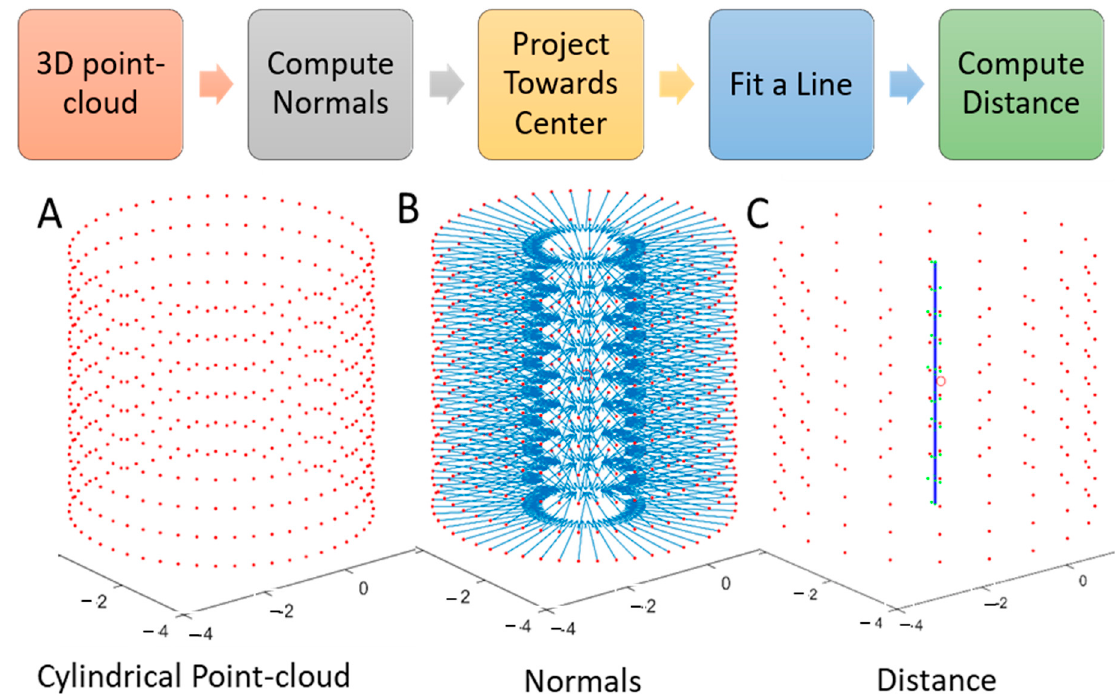
Figure 3. Algorithm to measure distance starting from cylinder-shaped 3D points. ( A ) ideal point-cloud; ( B ) normal computation and point projection; ( C ) distance